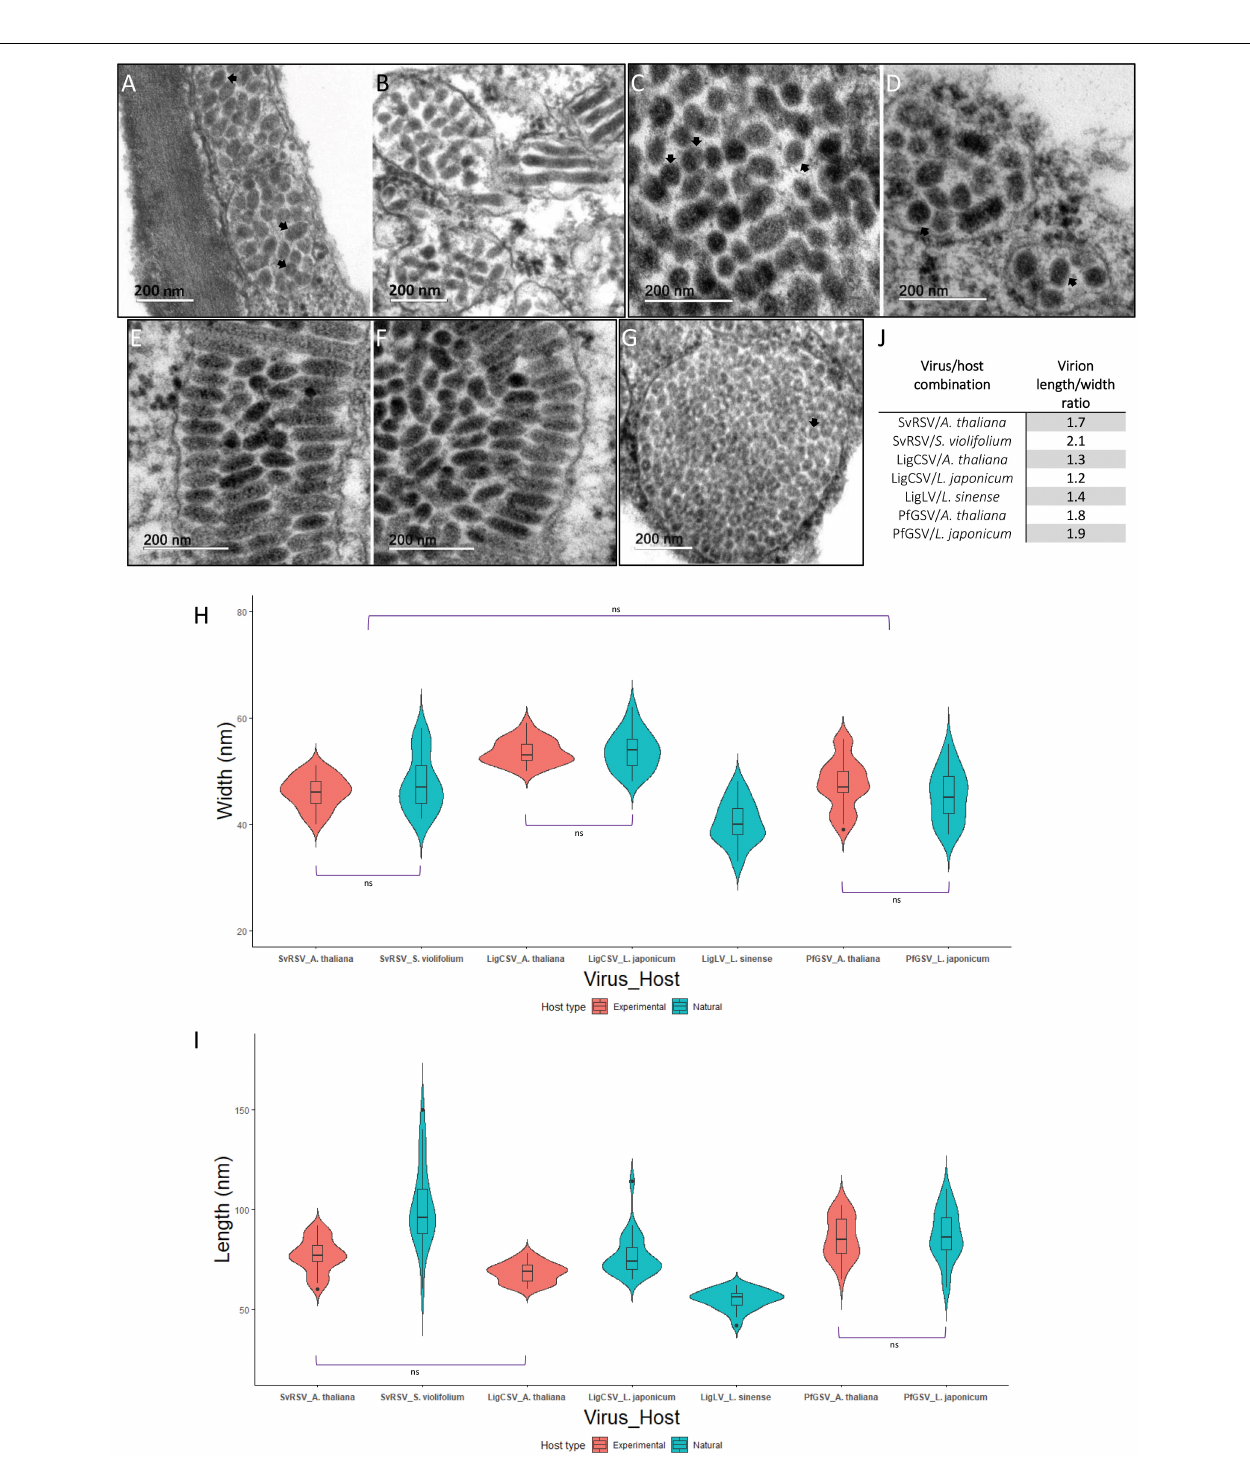
FIGURE 8 | Size and morphology of virions from SvRSV, LigCSV, and LigLV. Microphotographs of ultrathin sections of plants infected by SvRSV_Prb1, LigCSV_SPa1, and LigLV_Cdb1. (A,B) SvRSV in Arabidopsis thaliana and Solanum violifolium plants, respectively. (C,D) LigCSV in A. thaliana and Ligustrum japonicum plants. (E,F) PfGSV in A. thaliana and L. japonicum plants. (G) LigLV in L. sinense plant. (H,I) Violin plots represent the width and length of 25 viral particles measured in at least three micrographs of each virus/host combination. Values of each group were compared using the Wilcoxon signed-rank test. Horizontal brackets depict the results of the statistical test. ns: non-significant difference. In all other comparisons, significant differences were observed ( p < 0.05). A detailed description of statistical analysis results is described in Supplementary Tables 4, 5 . (J) Length/width ratio of virions from SvRSV, LigCSV, LigLV, and PfGSV in natural and experimental plant